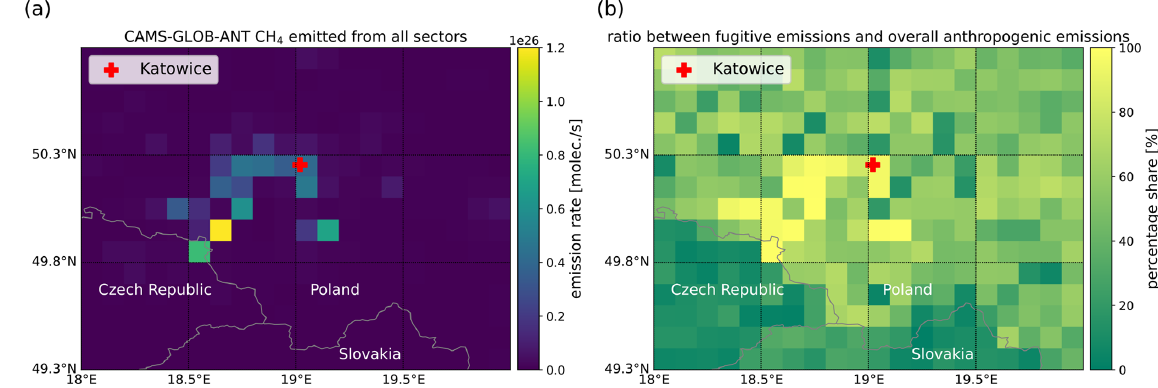
Figure 2. Spatial distribution of (a) the CAMS global anthropogenic emissions (CAMS-GLOB-ANT) from all sectors and (b) percentage share of the fugitive emissions compared to the overall anthropogenic emissions over the USCB region on a 0.1 ◦ × 0.1 ◦ latitude/longitude grid. The fugitives are the dominant CH 4